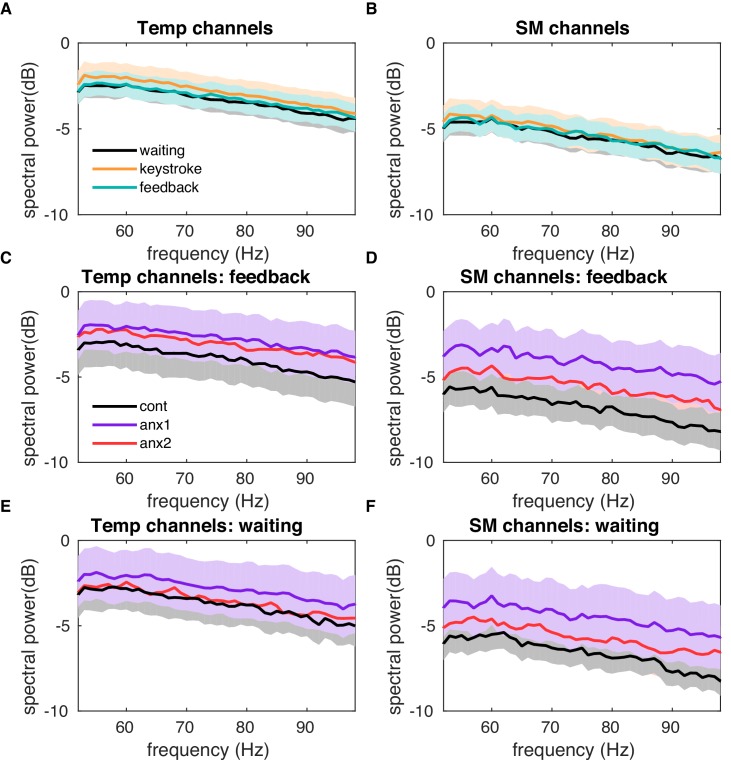
Higher gamma band activity analysis rules out an explanation in which muscle artifacts influence feedback-related changes in power.Broadband high-frequency gamma band activity, above 50 Hz, has been linked to muscle artifacts (Muthukumaraswamy, 2013). To rule out the possibility that muscle artifacts could explain the feedback-locked beta activity differences between experimental and control groups, we assessed the gamma (50–100 Hz) power activity in different conditions. (A) Gamma power is shown for these intervals: within 0–1 s after feedback presentation, when participants should be at rest after completing the trial performance (green line); within 0–1 s locked to a key press, when participants are moving their fingers (orange line); within 0–1 s locked to the initiation of the trial, when participants are cued to wait for the GO response, and can be expected to be mentally preparing but otherwise at rest (black line). Gamma power was averaged across temporal electrodes, where artifacts usually lead to larger effects. No differences between conditions were found (P>0.05). (B) Same as panel (A) but after averaging the gamma power values across all sensorimotor (SM) channels. No significant differences were found here either. (C, D) Gamma power locked to the feedback presentation is displayed separately in experimental and control groups in temporal (C) and sensorimotor channels (D). No significant between-group differences were found. (E, F) Same as panels (C–D) but during the waiting interval, when participants were waiting to initiate the trial.